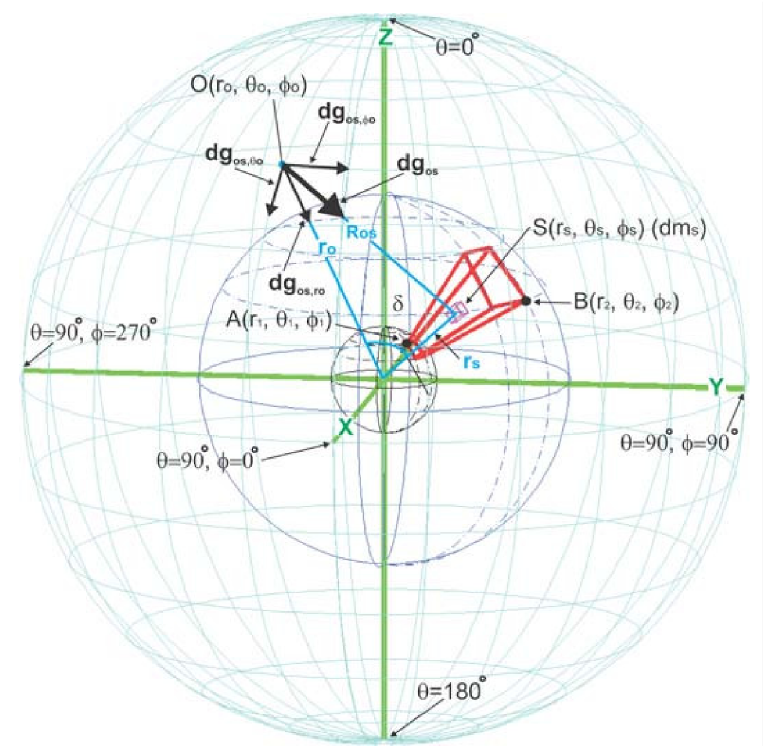
Figure A5. Spherical geometry for modelling at the observation point O ( r o , θ o , ϕ o ) the gravity effects of the spherical prism by integrating the differential source mass dm s through the volume of the prism with bottom and top surfaces that include the representative corner points A( r 1 , θ 1 , ϕ 1 ) and B( r 2 , θ 2 , ϕ 2 ),respectively. The Cartesian perspective is given by the superposed, co-registered X, Y, and Z axes (Reference from